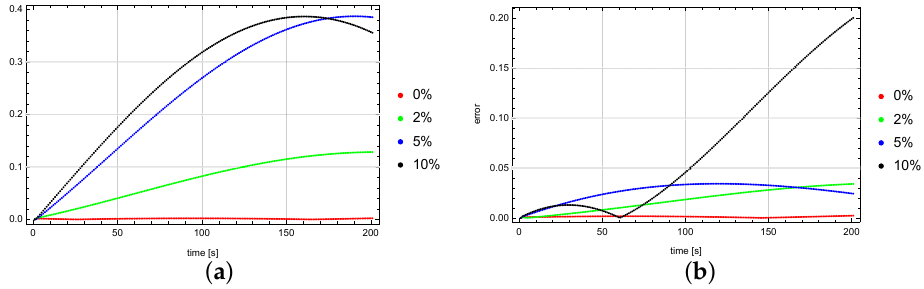
Figure 5. Errors in measurement points P 5 ( a ) and P 11 ( b ) in the case of a 100 × 100 × 200 mesh